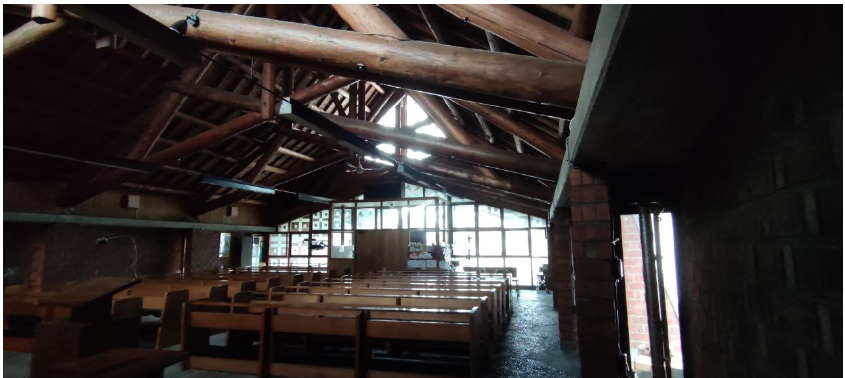
Figure 17. Inside view of Saint Michael’s Church.